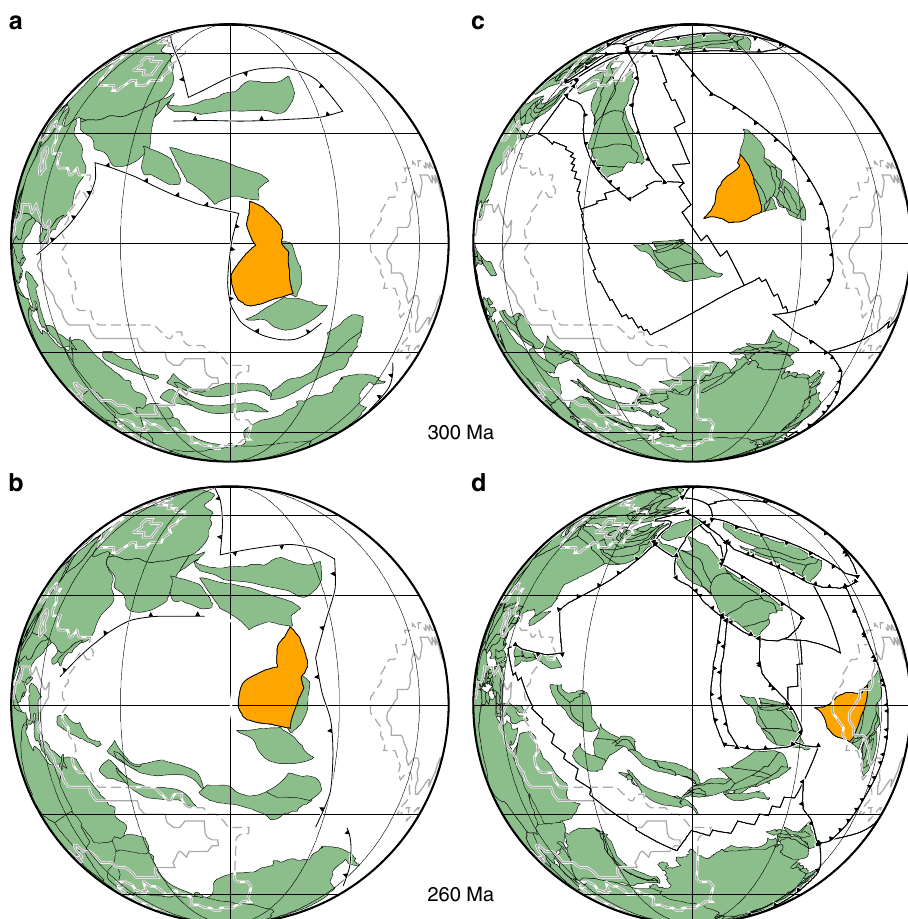
Fig. 1 Tectonic reconstructions of the Paleotethys Ocean during the Permian Period. a , b Reconstruction of Scotese and Langford 15 . c , d Reconstruction of Domeier and Torsvik 2 . In a and c , reconstructions are shown at 300 Ma, preceding the beginning of the Permian Era by 1 Myr. In b and d reconstructions are shown at the approximate age of the Emeishan eruption (260 Ma). Continental blocks are shown in green , with the exception of the South China block that carries the Emeishan volcanics, shown in orange . The thick black lines in c and d are plate boundaries (mid-ocean ridges, transform faults and subduction zones), with triangles denoting the overriding plate at subduction zones. Subduction zones are drawn at their approximate location based on ref. 15 in a and b , as these are not available digitally. The solid grey contour indicates a value of fi ve, and the dashed grey contour a value of one in a vote map of the location of LLSVPs in tomography models 12 . Orthographic projection centered on 90°E with graticules every 30° and the horizon at